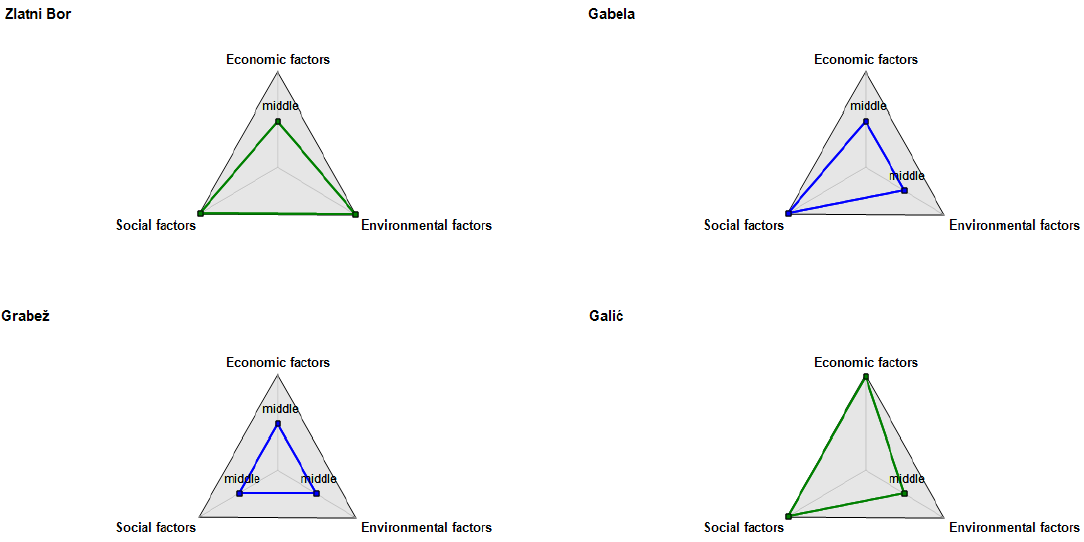
Figure 2. Evaluation of rural tourist facilities by the main criteria.